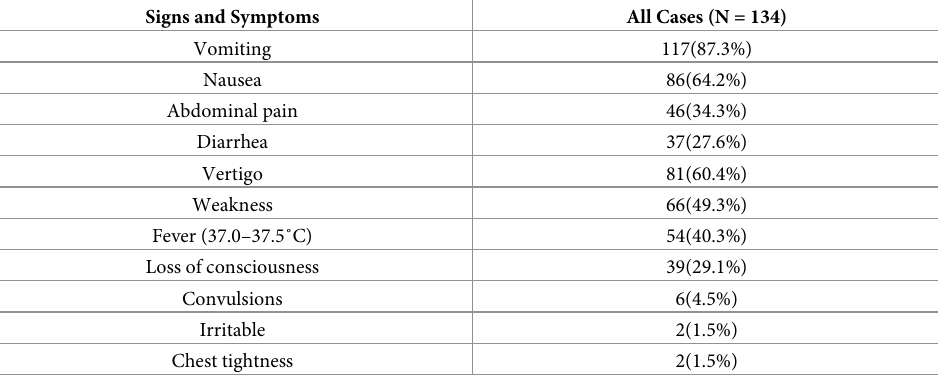
Table 2. Clinical manifestations of 134 cases with bongkrekic acid poisoning, China,